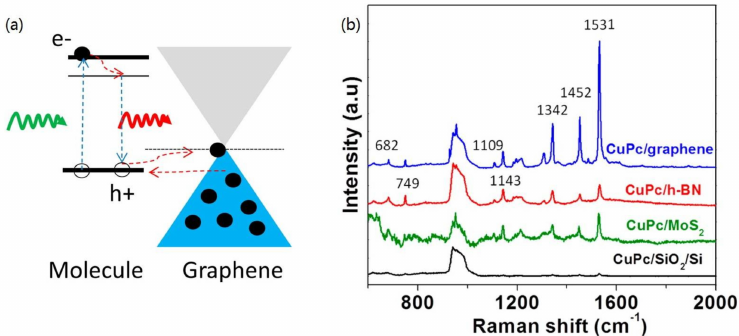
Figure 1. ( a ) Schematic of the Raman scattered process of graphene-enhanced Raman spectroscopy. Reproduced from [37] with permission; Copyright ACS 2012. ( b ) Raman spectra of the CuPc molecule on the blank SiO 2 /Si substrate, on graphene, on h-BN, and on MoS 2 substrates. The numbers marked on the peaks are the peak frequencies of the Raman signals from the CuPc molecule. Reproduced from [26] with permission; Copyright ACS